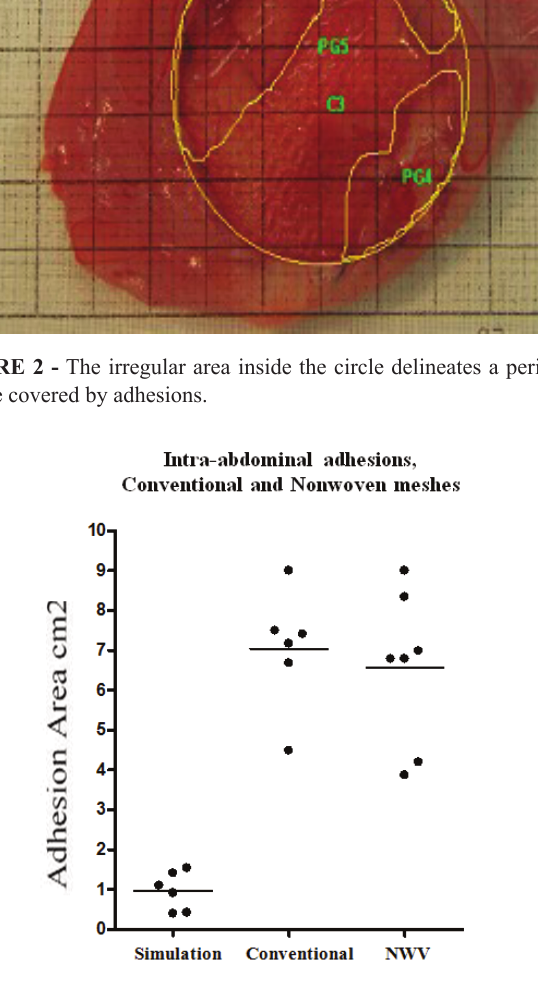
FIGURE 3 - Significant differences (p<0.05) can be observed comparing Groups 2 (Conventional) and 3 (Nonwoven - NWV) with Group 1.